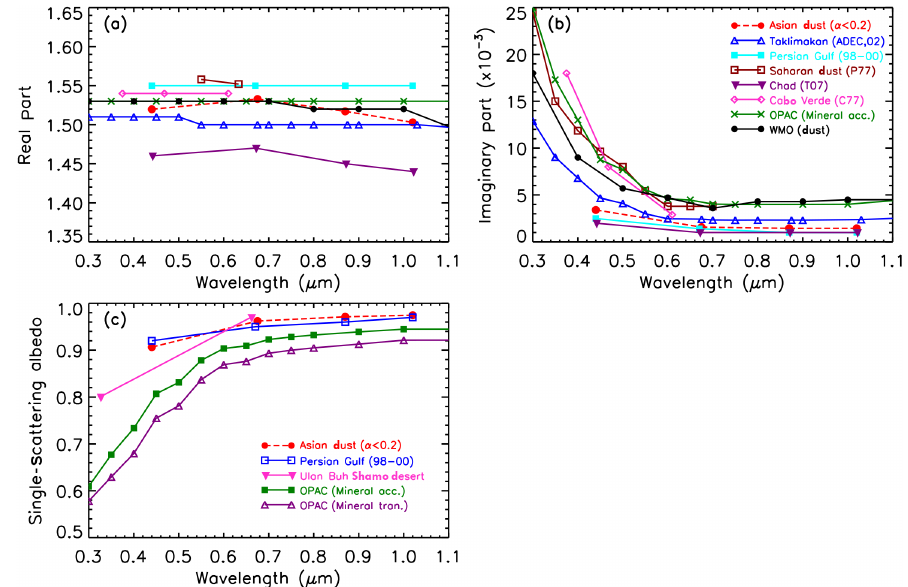
Figure 8. Mean spectral behaviors of (a) real part and (b) imaginary part of complex refractive index and (c) single-scattering albedo for Asian Pure Dust ( α <0.2) calculated for 13 AERONET sites, and results of current common dust models (OPAC, WMO). Bahrain–Persian Gulf desert dust (1998–2000), Saharan dust (Chad, Cabo Verde), and Chinese Gobi desert (Taklimakan Desert, Ulan Buh Shamo desert) are also shown for